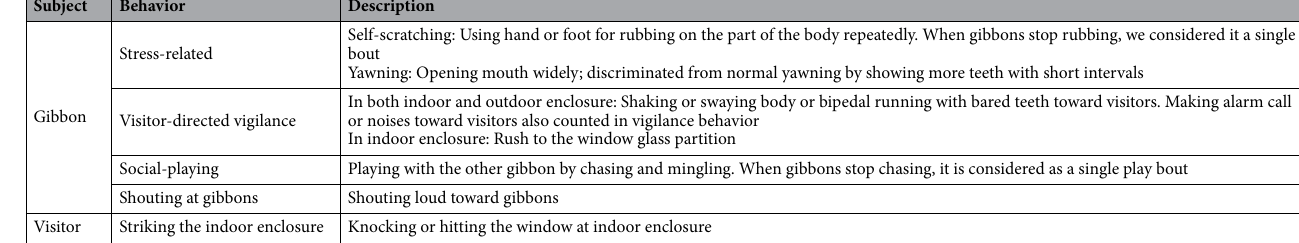
Table 1. Ethogram of gibbon and visitor’s behaviors recorded using focal and scan sampling in the study. *Each behavior is considered as a single bout if the behavior lasts for at least 5